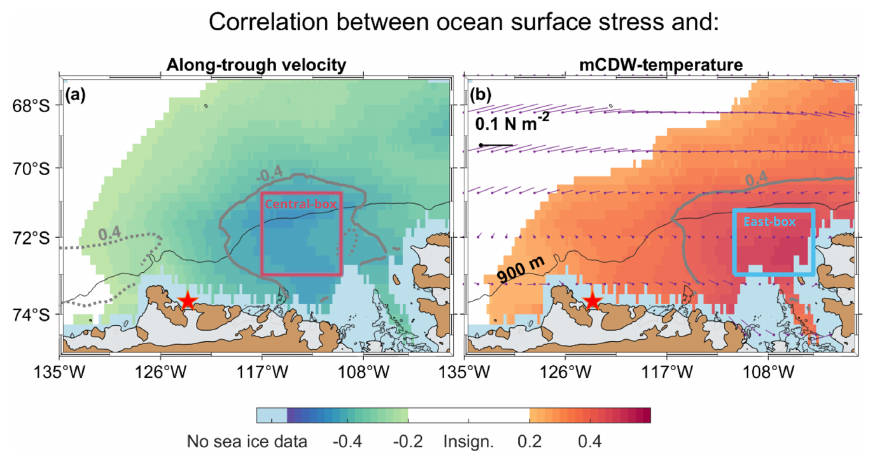
Figure 5. Spatial distribution of significant correlation during winter (colors) between zonal τ D18 and (a) depth-averaged along-trough velocity at GC 6 , and (b) mCWD temperature at GC 6 . The correlation calculations are based on BP 8D–10M -filtered time-series averaged to daily values. Light blue regions along the coast indicate missing data on sea ice movement and white indicates insignificant correlation. Gray contours indicate a correlation of ± 0 . 4 for winter (solid) and summer (dashed). The (a) red and (b) cyan boxes mark the areas used for average τ D18 in Fig. 6. The red star and black contour mark GC 6 and the 900m isobaths respectively. In (b) , the purple lines with dots at their origin indicate mean τ D18 (scale in black). Values over land are removed.